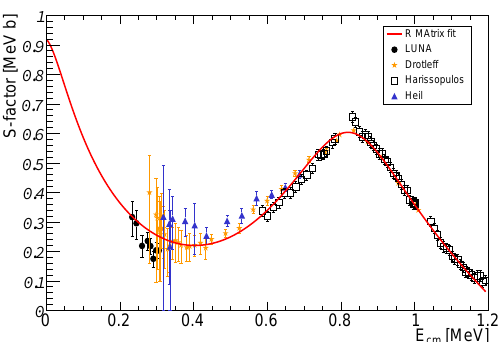
Figure 2: (Colour online) R-matrix extrapolation (red curve) of the astrophysical S(E) factor of 13 C( α ,n) 16 O calculated using the new LUNA dataset together with the Heil, Drotle ff and Harissopulos data. The figure is adapted from